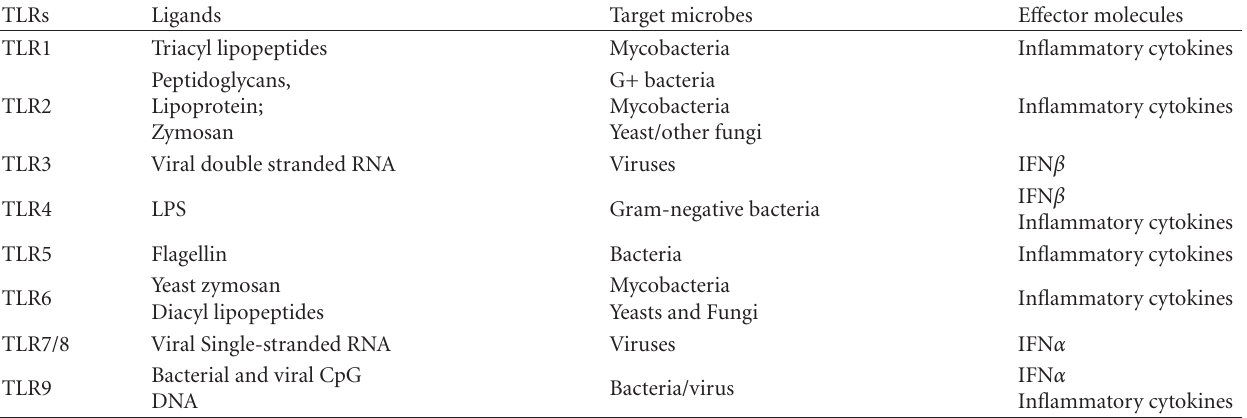
Table 1: Toll-like receptors and their ligands, target microbes, and e ff ector molecules are